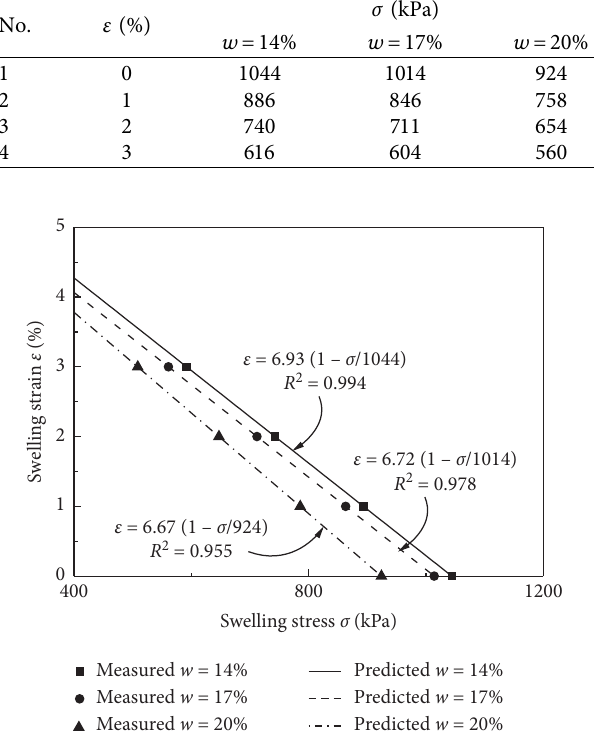
Figure 7: Comparison of measured and calculated swelling test data for swelling rock of Liu et al.